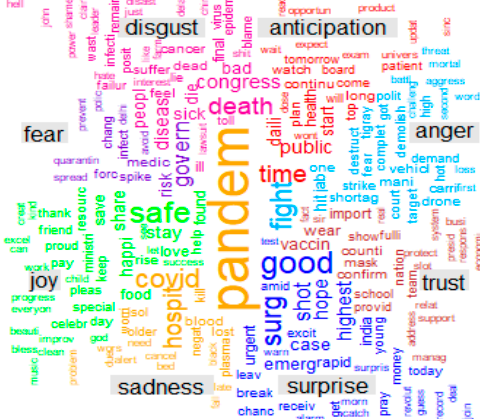
Figure 2. Wordcloud of emotions during infectious disease in April 2021.